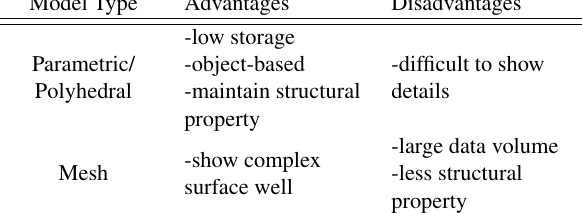
Table 1. Comparison of parametric/polyhedral and mesh-based modeling approaches from 3D point clouds